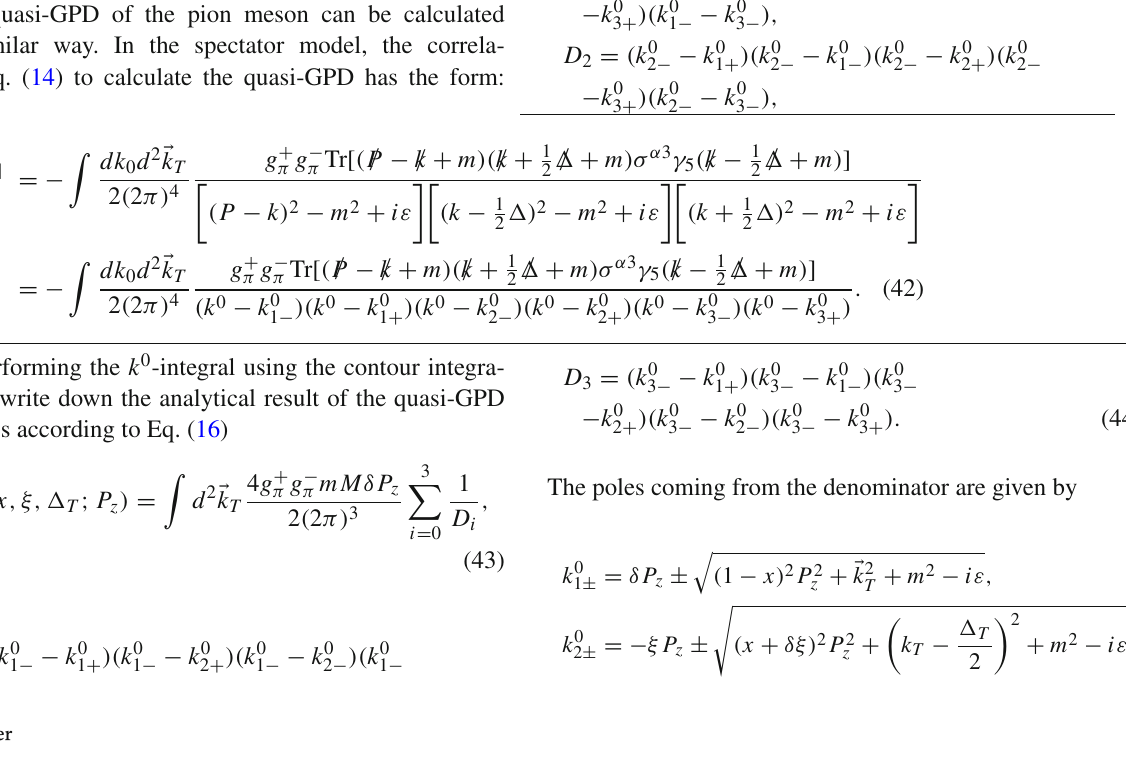
| for different ξ and |(cid:2) (cid:3) | values. The upper and lower panels display T T ( x ,ξ, (cid:2) k 2 , (cid:2) (cid:3) 2 ) at | (cid:2) (cid:3) | = 0 and 0 . 1, T T T 1